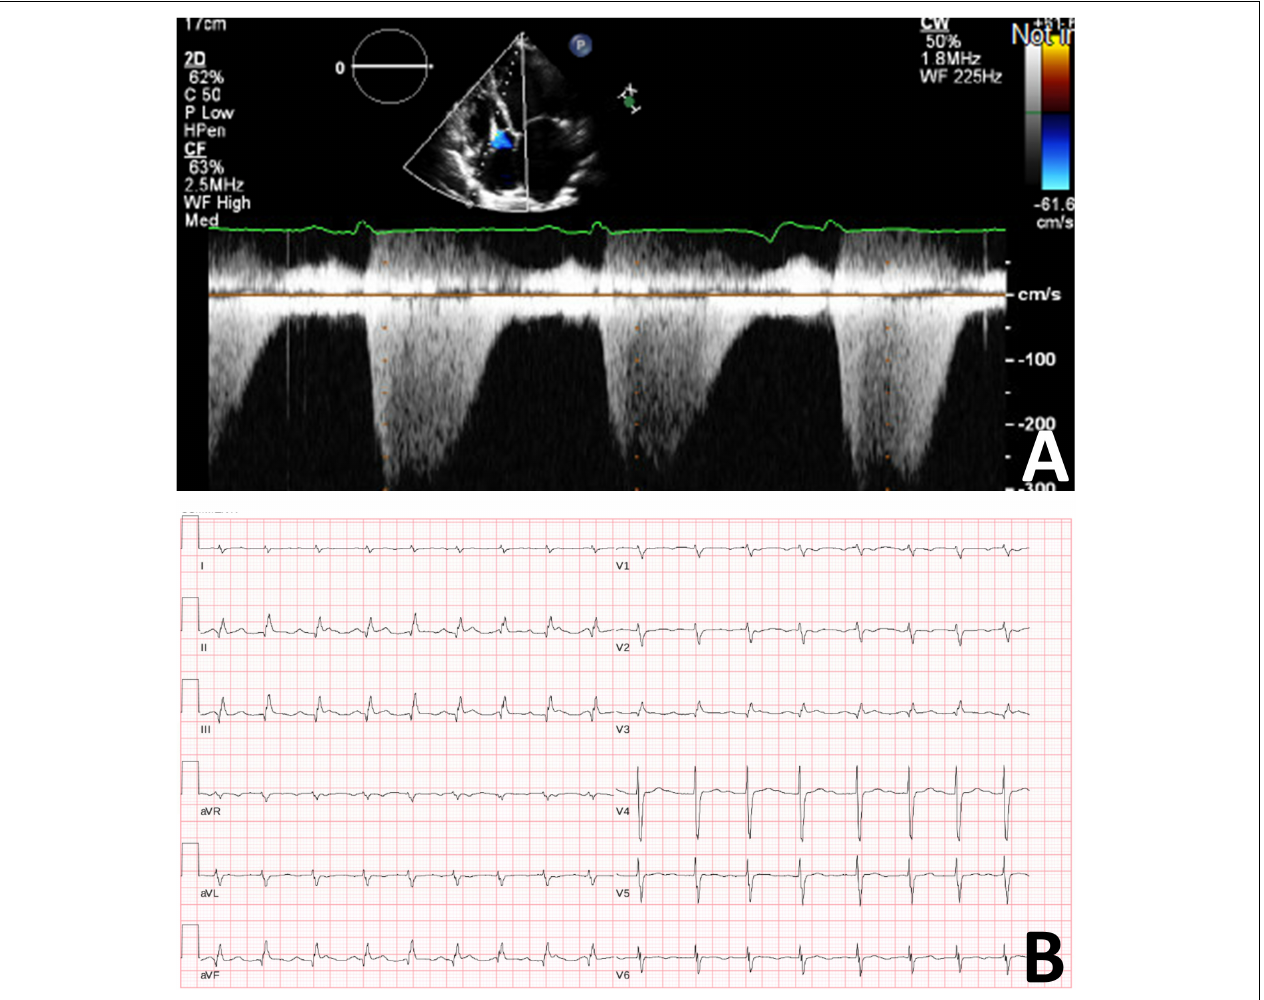
FIGURE 3 | (A) Transthoracic cardiogram demonstrating severely reduced LV function with severe biatrial enlargement. (B) Electrocardiogram demonstrating sinus tachycardia with second degree A-V block (Mobitz